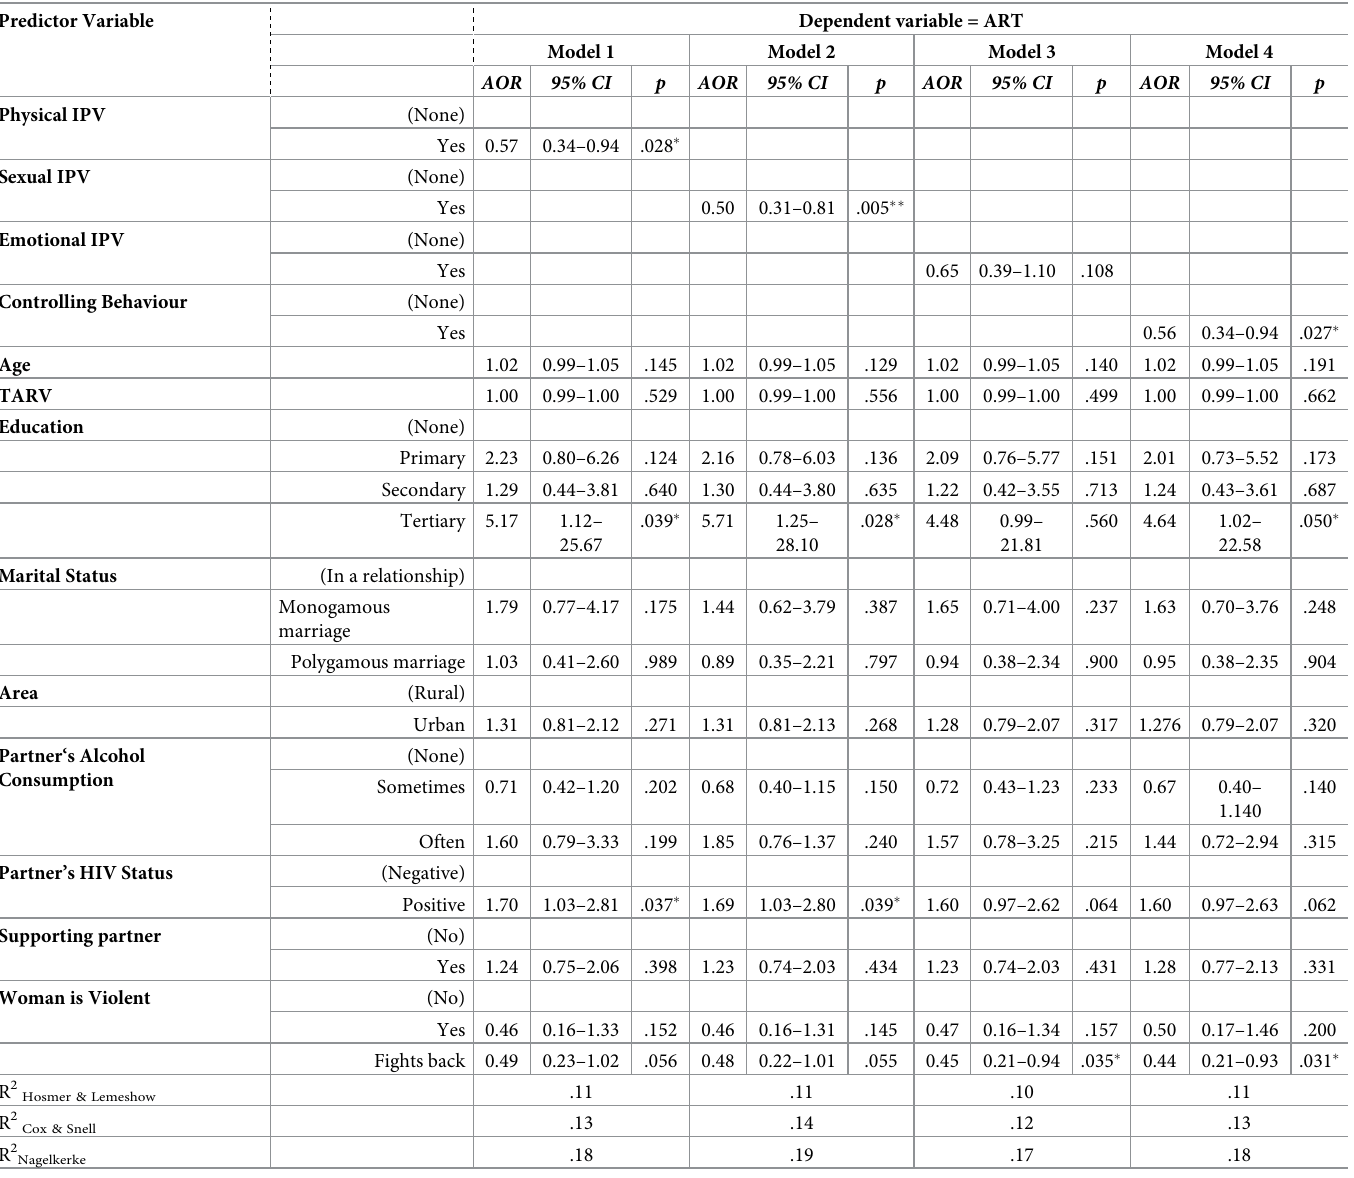
Table 2. Multiple regression models of factors associated with ART